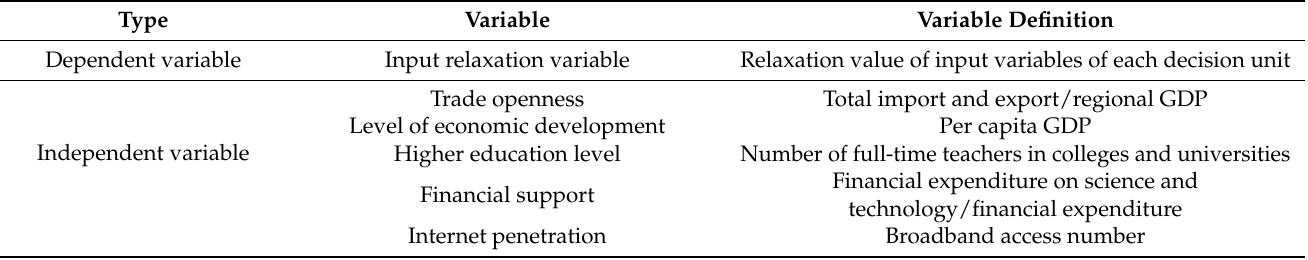
Table 2. Environmental variables of the SFA model in the second